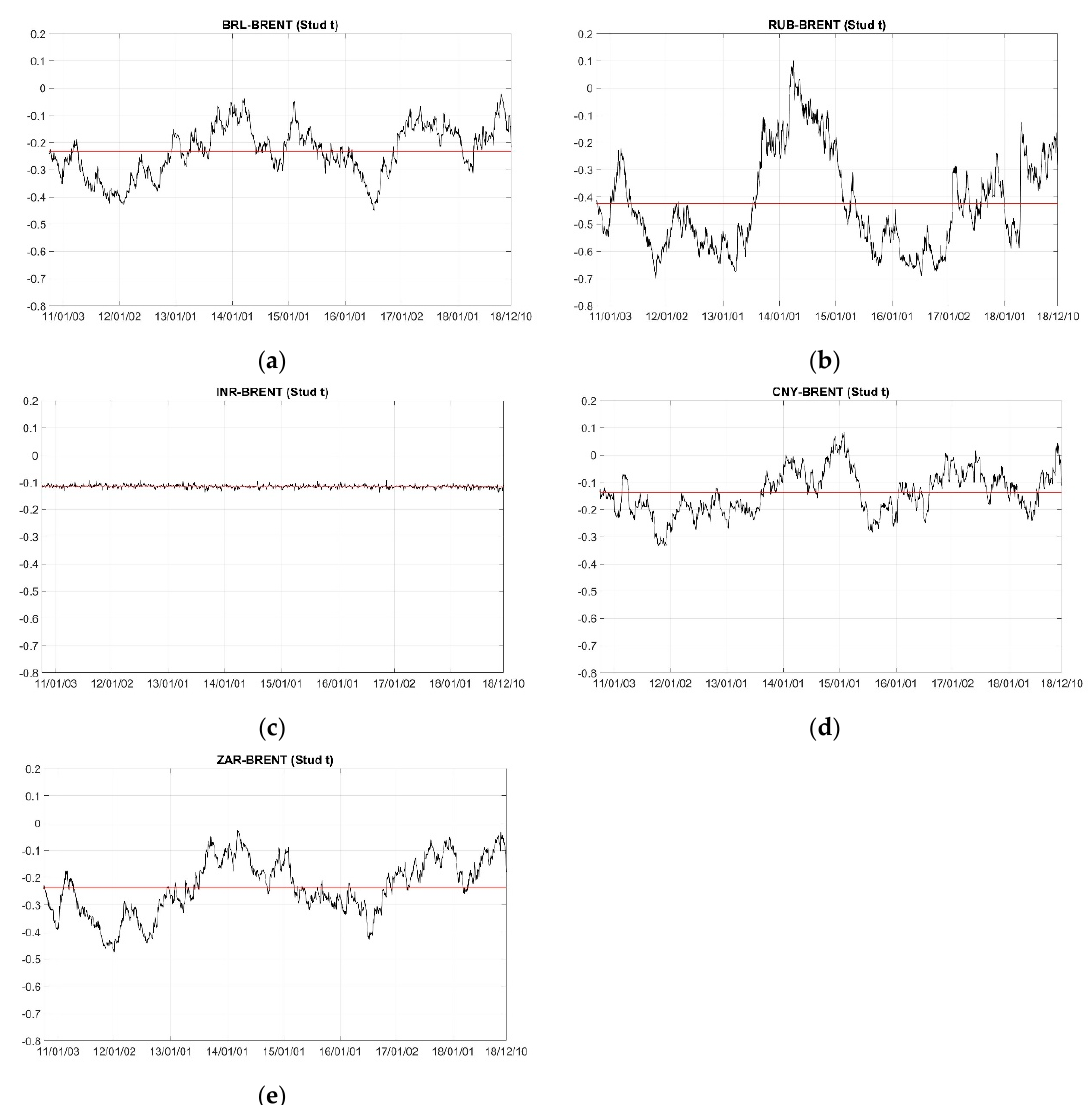
Figure A1. Dynamic parameters from the time-varying copula models. ( a – e ) refer to BRL–BRENT, RUB–BRENT, INR–BRENT, CNY–BRENT and ZAR–BRENT pairs, respectively.